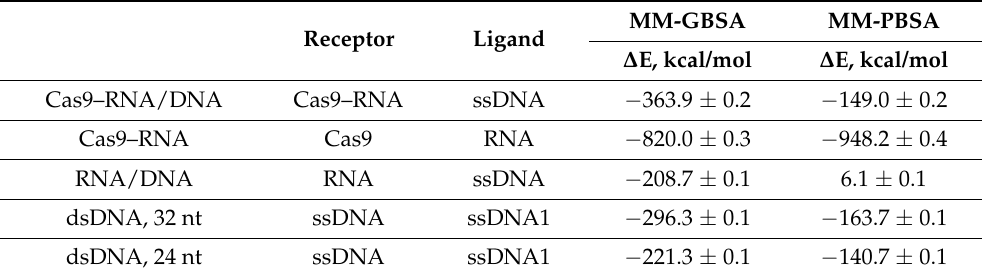
Table 2. Values of complex formation energies obtained with MM-GBSA and MM-PBSA.